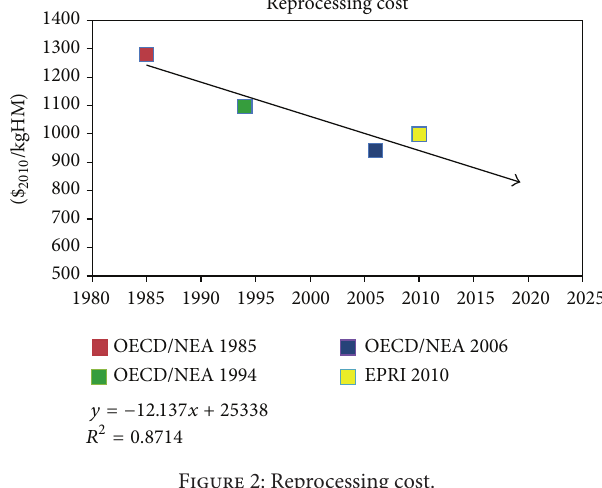
Figure 2: Reprocessing